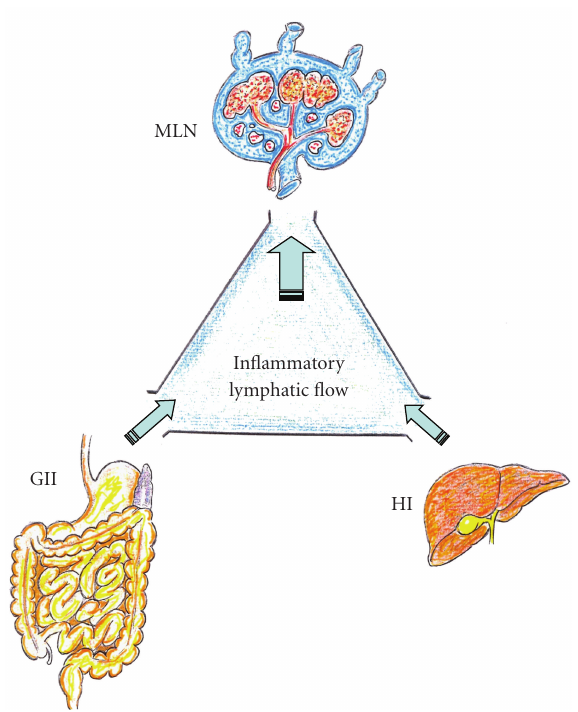
Figure 2: Chronic low-grade splanchnic inflammation in the portal hypertensive syndrome increases mesenteric lymphatic flow. GII: Gastrointestinal interstitium; HI: Hepatic interstitium; MLN: Mesenteric lymph